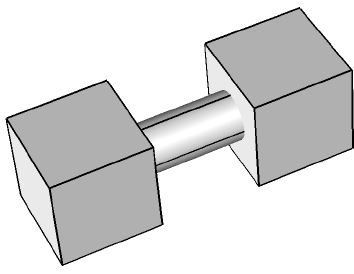
Fig. 3: Example geometric model.